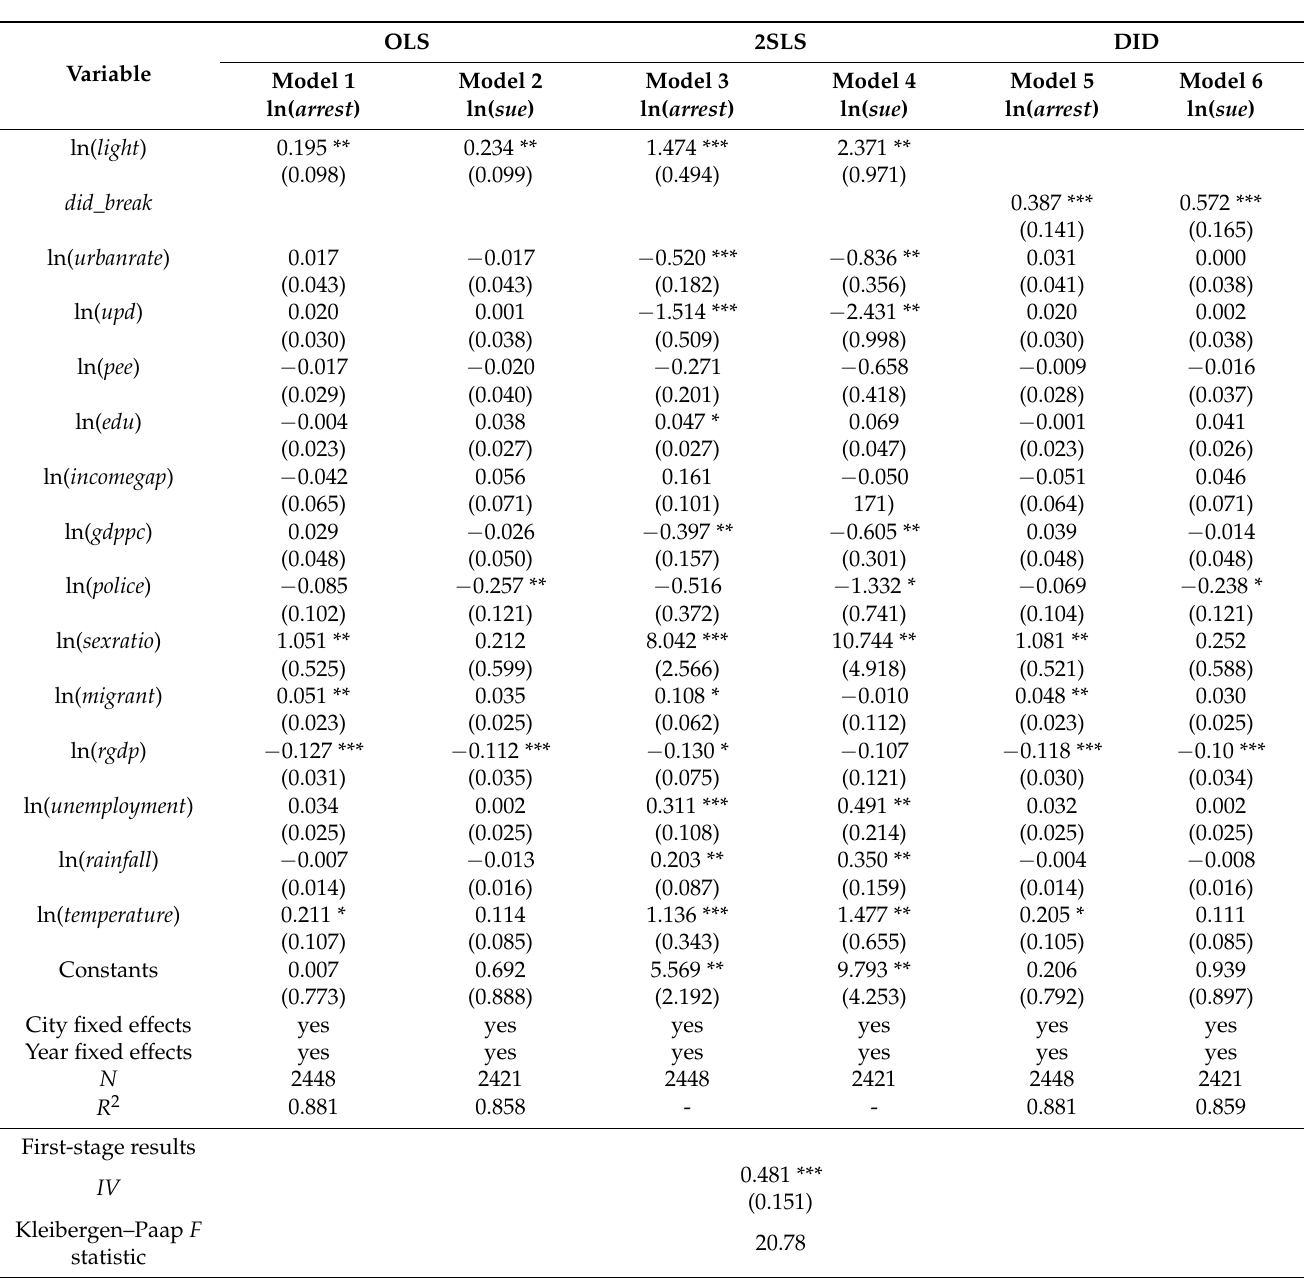
Table 2. Regression results for the effect of nighttime light on urban crime